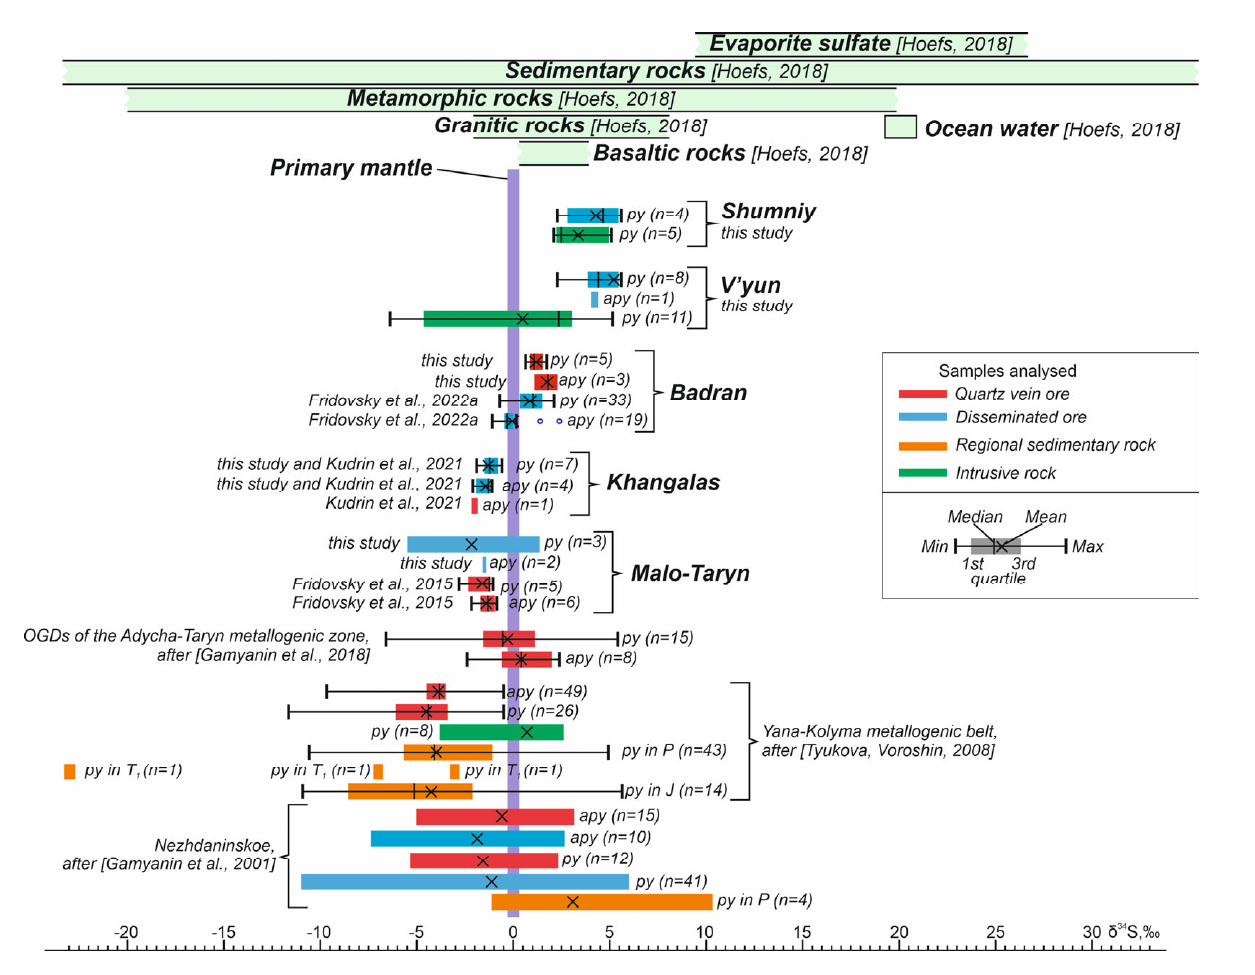
Figure 24. Summary of δ 34 S values for orogenic gold deposits in the Yana–Kolyma metallogenic belt and the Nezhdaninskoe deposit, NE Russia. For comparison, materials according to [11,12,21,23,28,39]. Ranges of sulfur isotopic composition in various geological reservoirs according to [146]. In sudfigure: the left border of the line shows the minimum value; the right one shows the maximum value; vertical lines in the boxes denote the median, the X marks in the boxes denote the mean, and the left and right of each box denote the first and third quartiles, respectively.